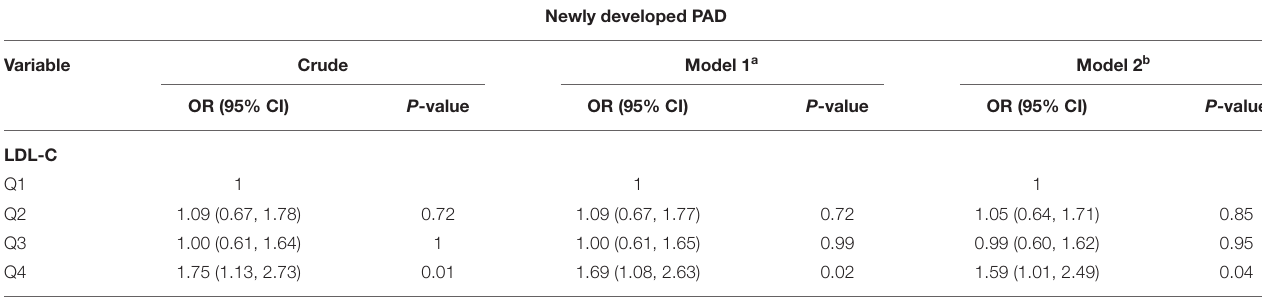
TABLE 2 | Odds ratios (OR) for newly developed peripheral artery disease (PAD) for low-density lipoprotein cholesterol (LDL-C) burden. Newly developed PAD